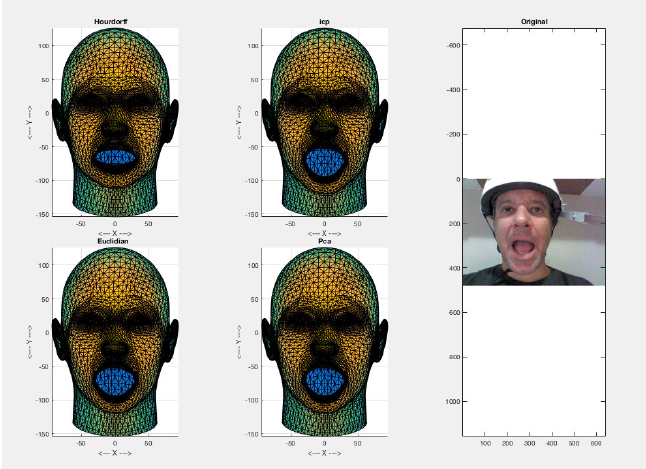
Fig. 7. Example of applying weights in